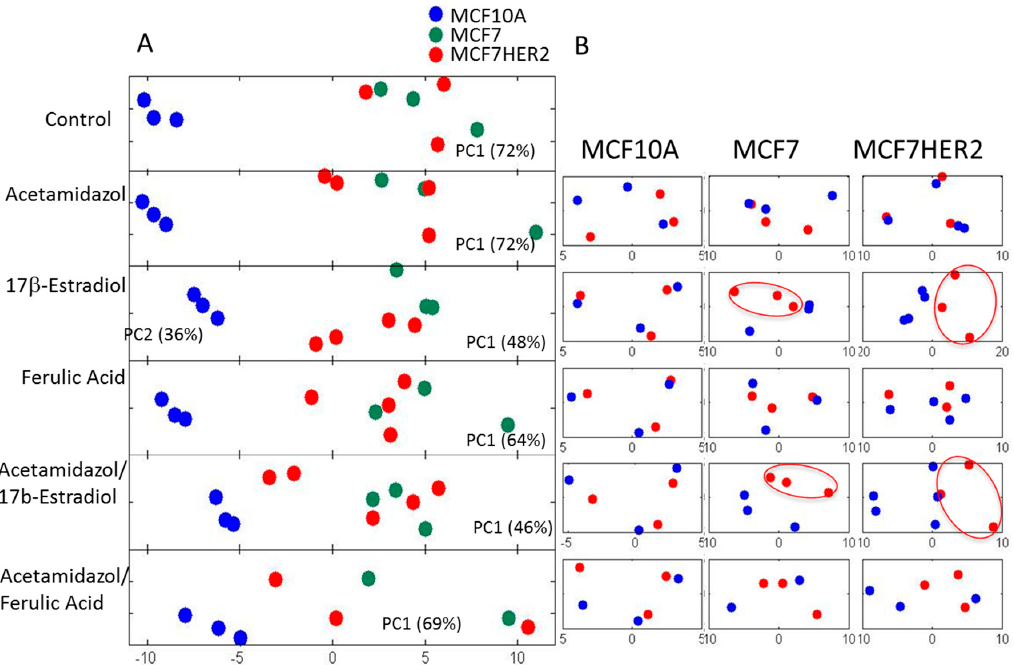
Figure 4. PCA of spectra of hydrophilic profiles for samples in three cell lines with different treatments. ( A ) PCA of spectra of hydrophilic profiles. ( B ) Individual comparisons between control (blue dots) and treated samples (red Dots) in the three cell lines. PC1—principal component 1 score shows percentage of variance between samples that is represented by PC1 axes; PC2—principal component 2 shows percentage of variance between samples that is represented by PC2 axes. Percentage separation was shown wherever there is a visible separation between sample groups. Separation of sample groups in any principal component axis is more significant if the percent score is larger. The third replicate in the acetamidazol/ferulic acid treatment of MCF7 cells was not included due to the quality of the NMR signal.